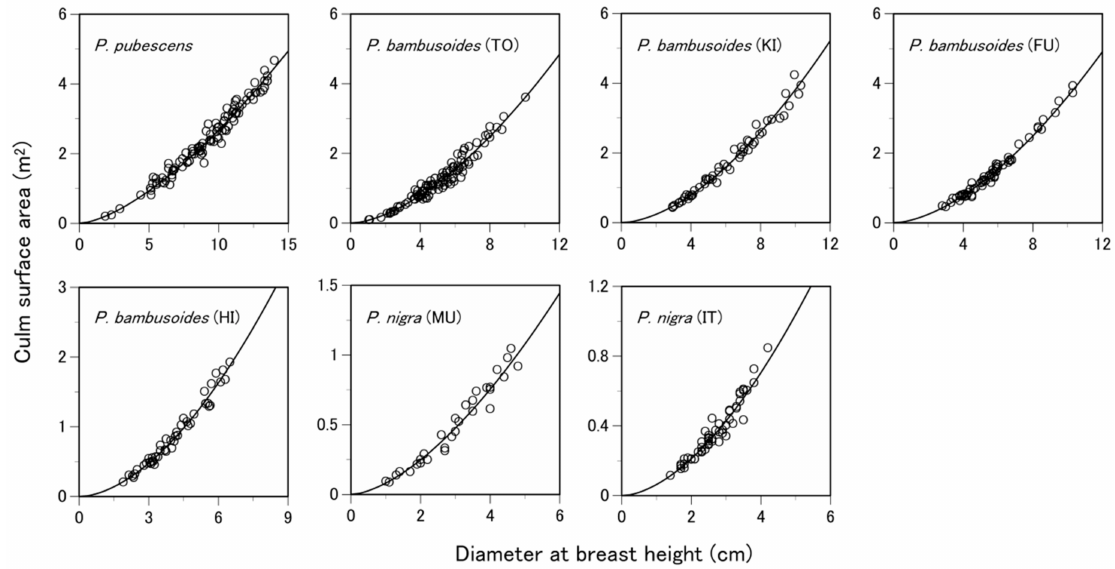
Figure 1. Relationship between culm surface area and diameter at breast height for each species and site. The solid lines represent the power equations detailed in Table 3.